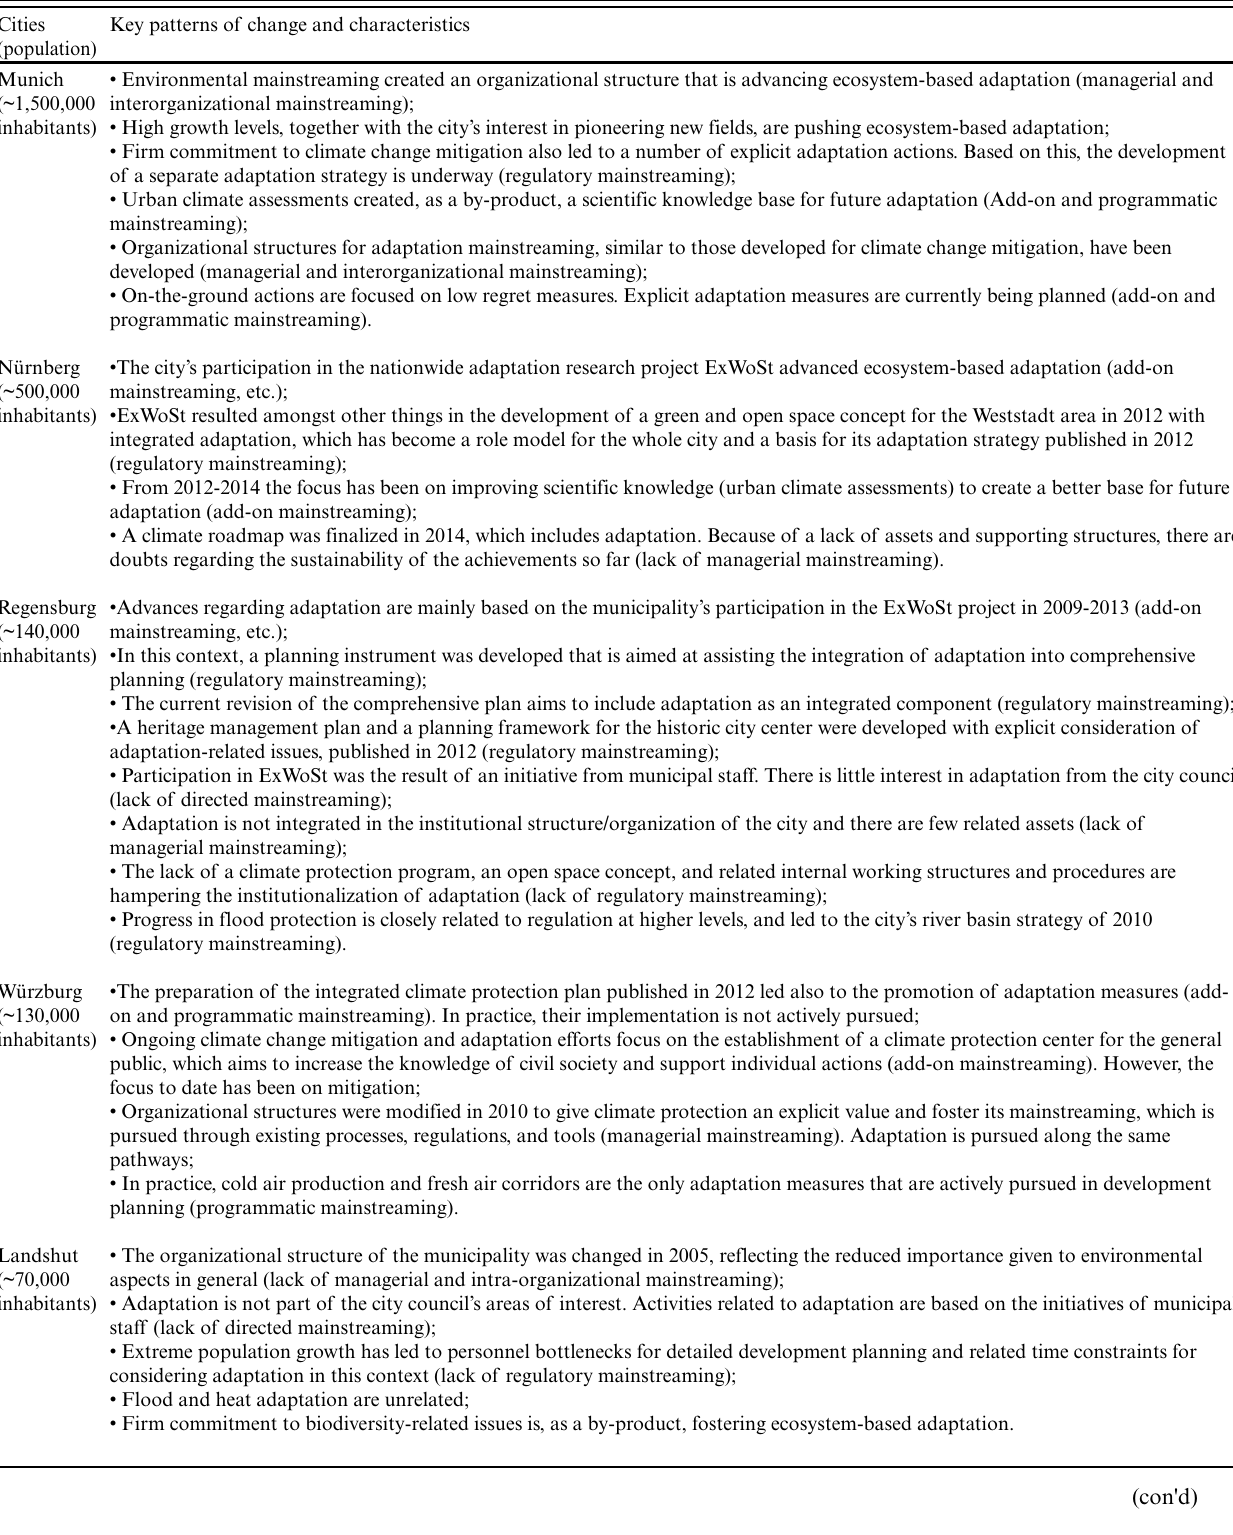
Table 2 . Key characteristics of single-case